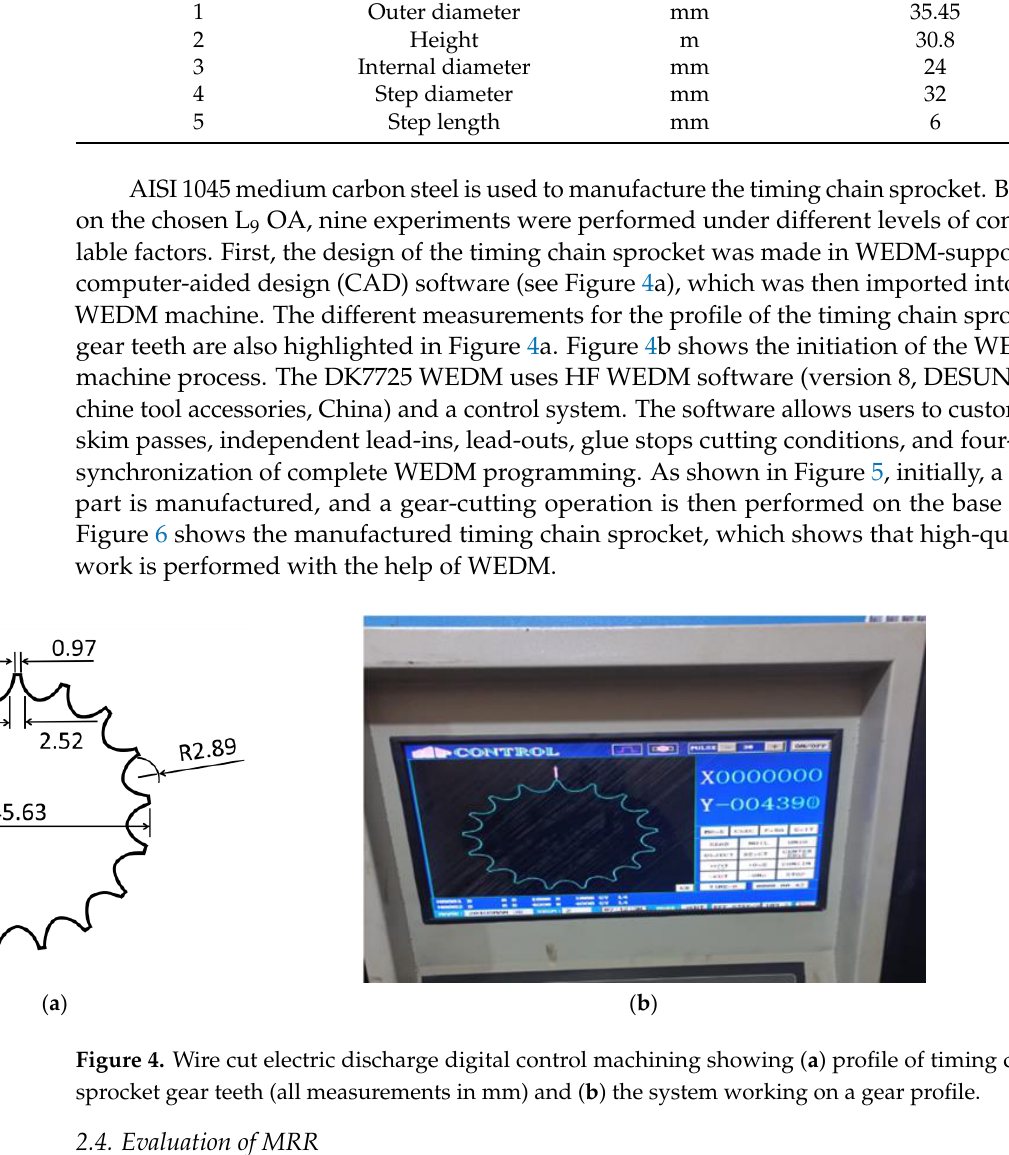
Table 8. Dimensions of timing chain sprocket. Ser No.